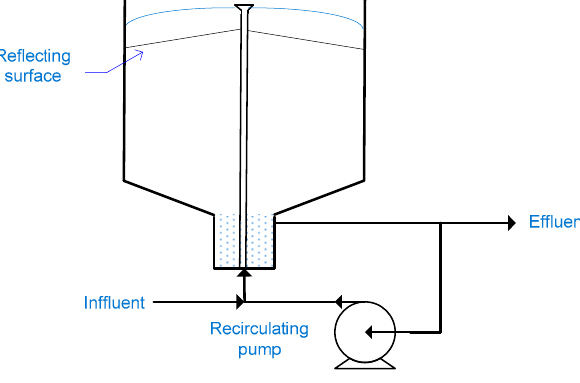
Figure 6. Schematic drawing of fountain reactor.